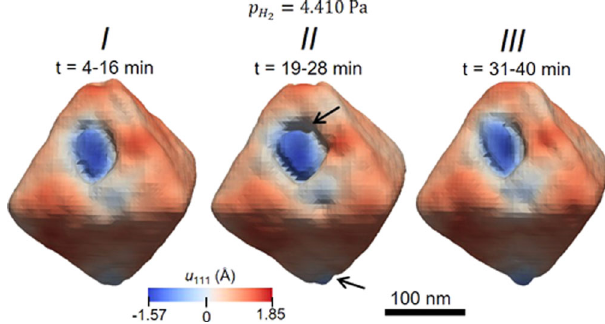
Fig. 5 Displacement fi eld evolution during the hydrogen exposure = 4.410 Pa). Time evolution of the morphology and measurement ( p H 2 surface displacement distribution for the same Pd nanoparticle measured under a hydrogen gas atmosphere. The hydrogen exposure time ( t ) is